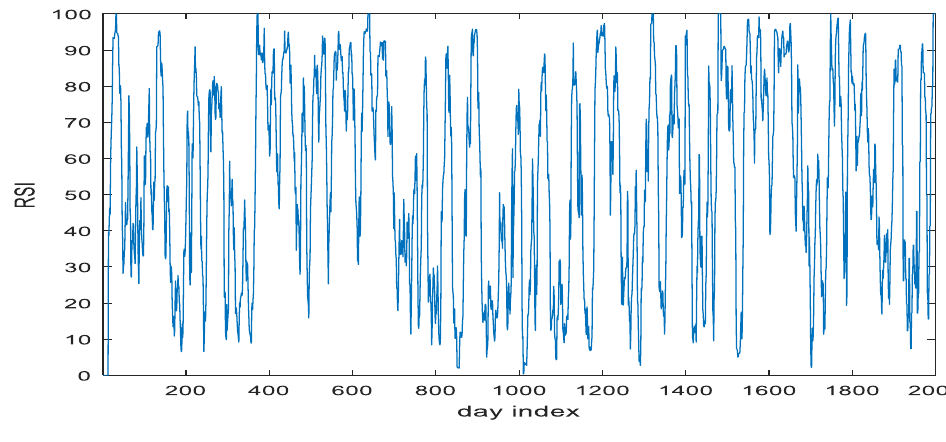
Figure 7. RSI oscillator on test